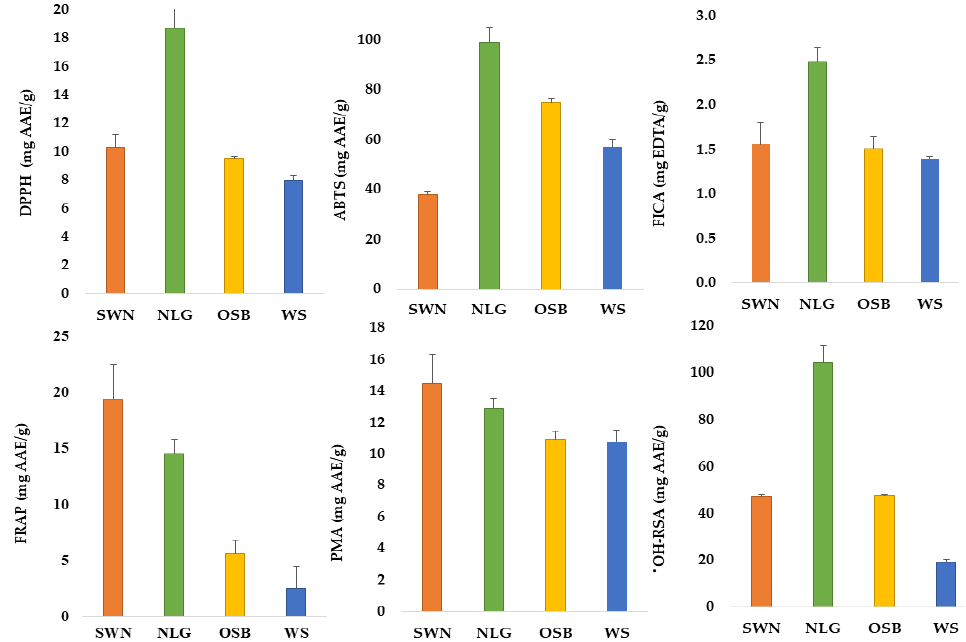
Figure 1. Antioxidant activities of Australian native lemongrass (LG), sandalwood nuts (SWN), wattle seeds (WS), and old man saltbush (OSB).